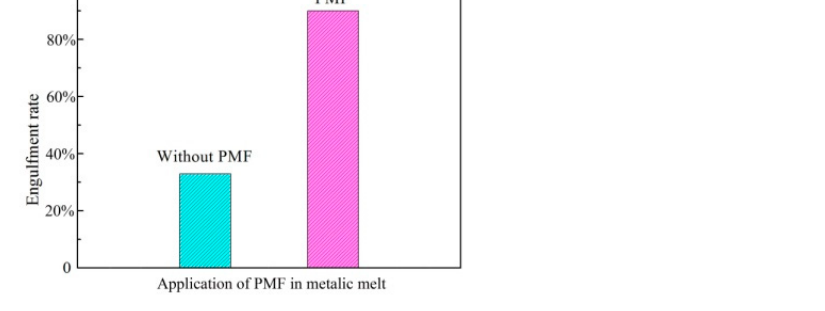
Figure 7. Optical microscope images of samples ( a ) without PMF and ( b ) with PMF.